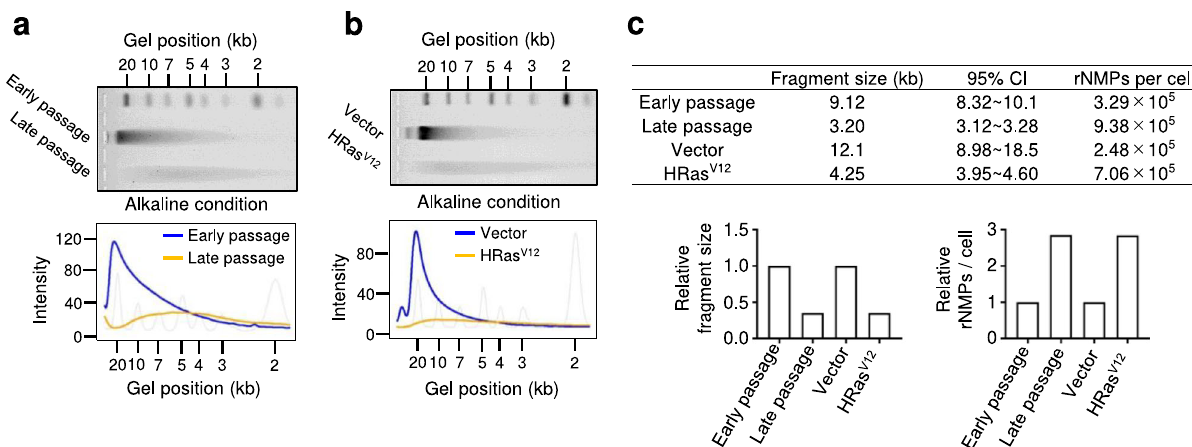
Fig. 3 Residual ribonucleoside monophosphate levels in genomic DNA are increased in senescent cells. a Top: Genomic DNA was extracted from pre- senescent (early-passage) or senescent (late-passage) TIG-3 cells and then subjected to alkaline gel electrophoresis following alkaline hydrolysis. The representative gel is shown from three biological replicates. Bottom: The density curves of the gel image are shown. b Top: Genomic DNA was extracted from pre-senescent (vector) or ectopic expression of oncogenic ras (HRas V12 ) TIG-3 cells and then subjected to alkaline gel electrophoresis following alkaline hydrolysis. The representative gel is shown from three biological replicates. Bottom: The density curves of the gel image are shown. c The fragment sizes and numbers of ribonucleoside monophosphates (rNMPs) for each condition were estimated by the mathematical model with respect to representative